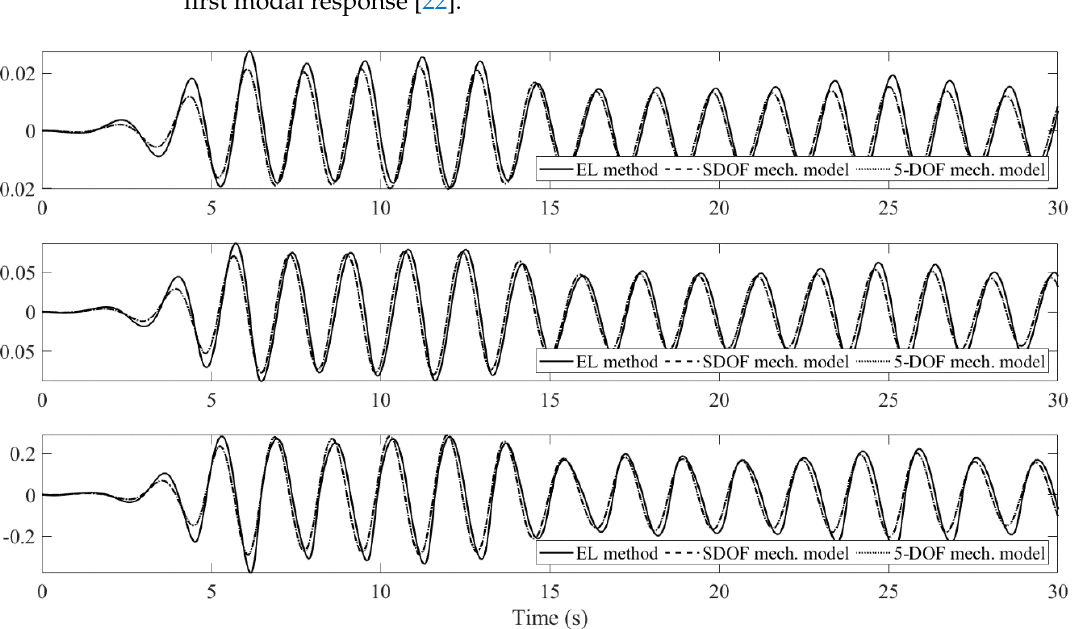
Figure 13. The overturning moments acting on the floating body for the large-wave case. When the small wave excitation was applied, the body motions and the resultant forces along three directions are shown in Figures 14–19. The overall trends were similar to what was observed for the large-wave cases. However, the smaller wave loadings caused a smaller body vibration, hence lowering the nonlinear effect in the sloshing reac- tions. The mechanical model captured the pitch motion more easily. Similarly, the result- ant forces and body dynamics by the SDOF and five-DOF mechanical systems highly co- incided.